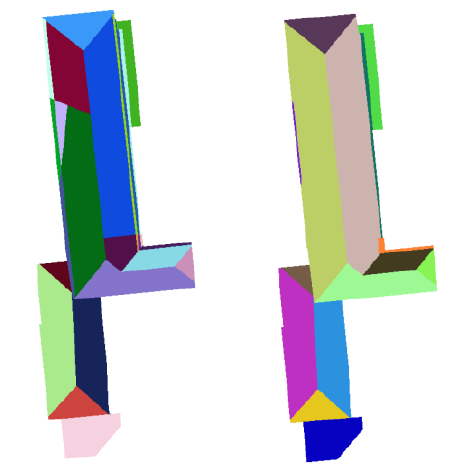
Figure 6. The result of the binary space partitioning which takes building knowledge into account before (left) and after (right) the merging